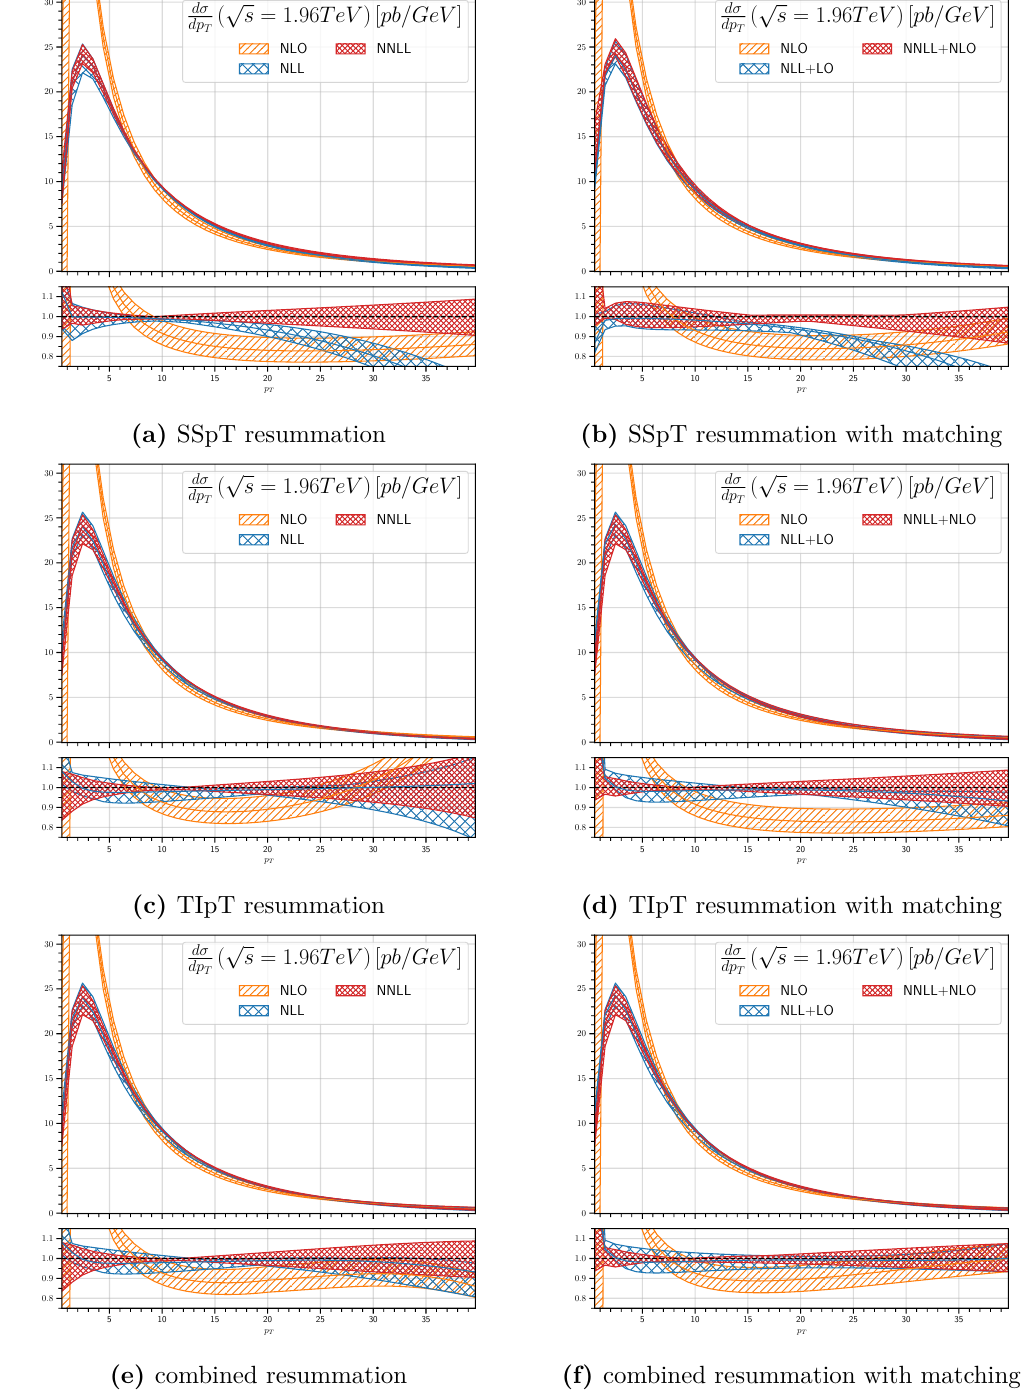
Figure 6. p T spectrum of the Z boson production for various types of resummation: standard small- p T ( top ), threshold-improved small- p T ( middle ), and combined ( bottom ). The left plots show the pure resummation results while those matched to the fixed-order are shown on the right . The top panels compare the NLL and NNLL resummed results to the NLO. The lower panels show the ratio w.r.t. to the central value of the respective NNLL results. The uncertainty bands are computed by varying µ R and µ F using the 7-point method; in all cases, Q = m Z .